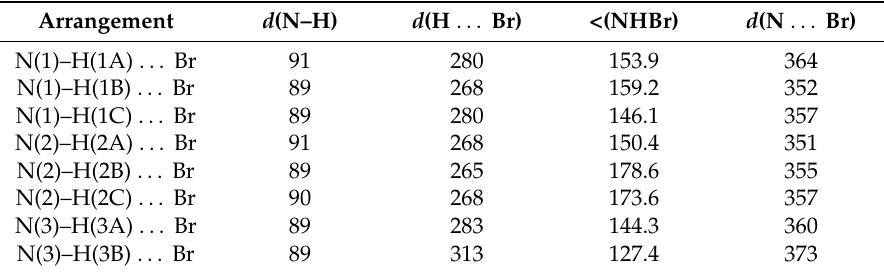
Table 7. Donor–acceptor distances (pm) and angles (deg.) in [Zn 2 (NH 3 ) 2 (NH 2